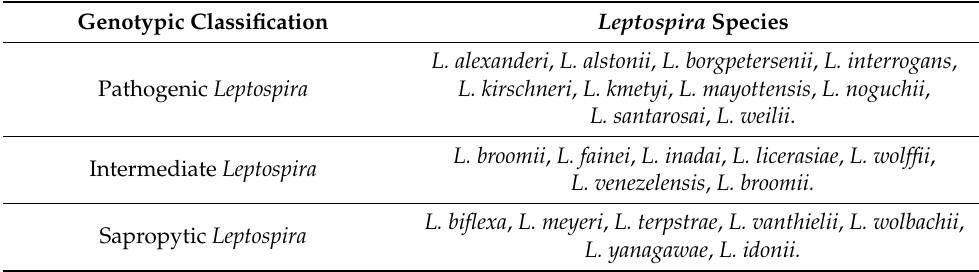
Table 1. Example of pathogenic, intermediate and saprophytic Leptospiral